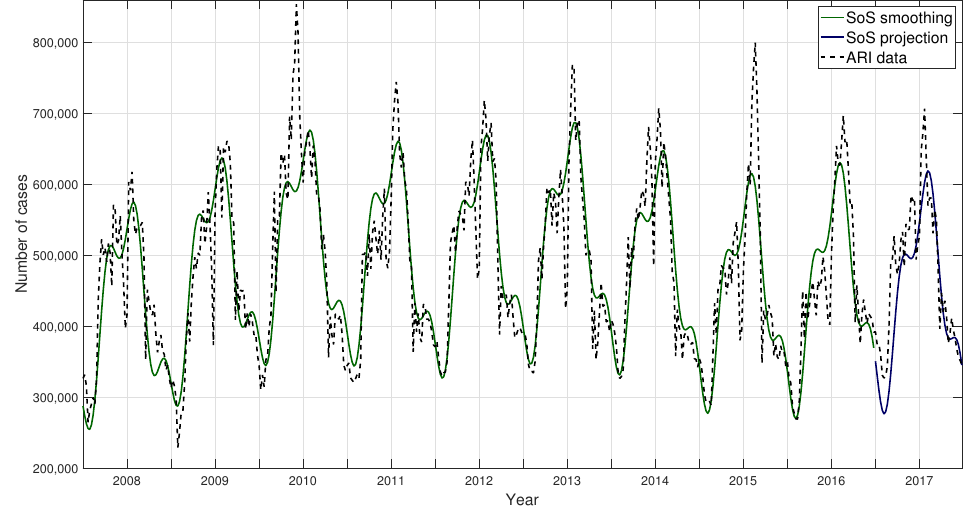
Figure 7. ARI data and sum of sines (SoS) fitted